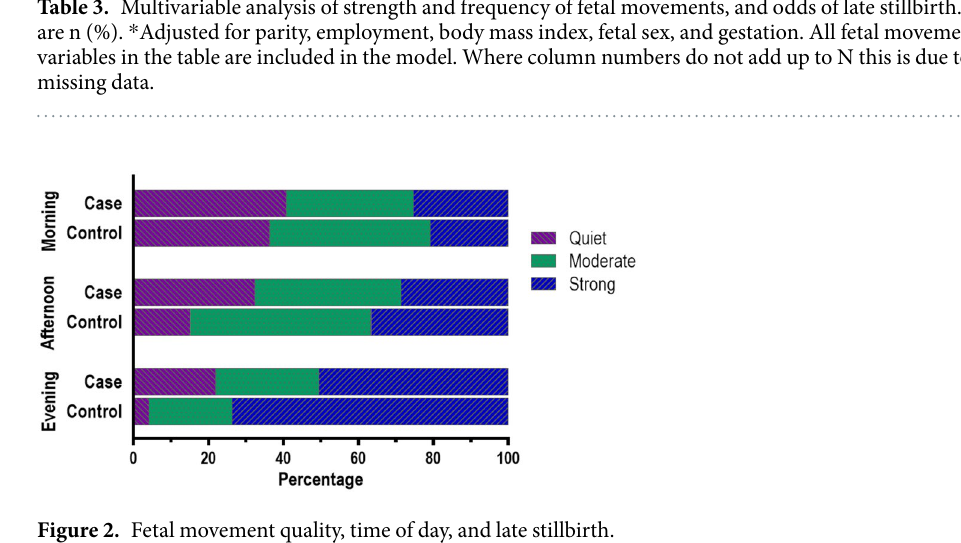
Figure 2. Fetal movement quality, time of day, and late